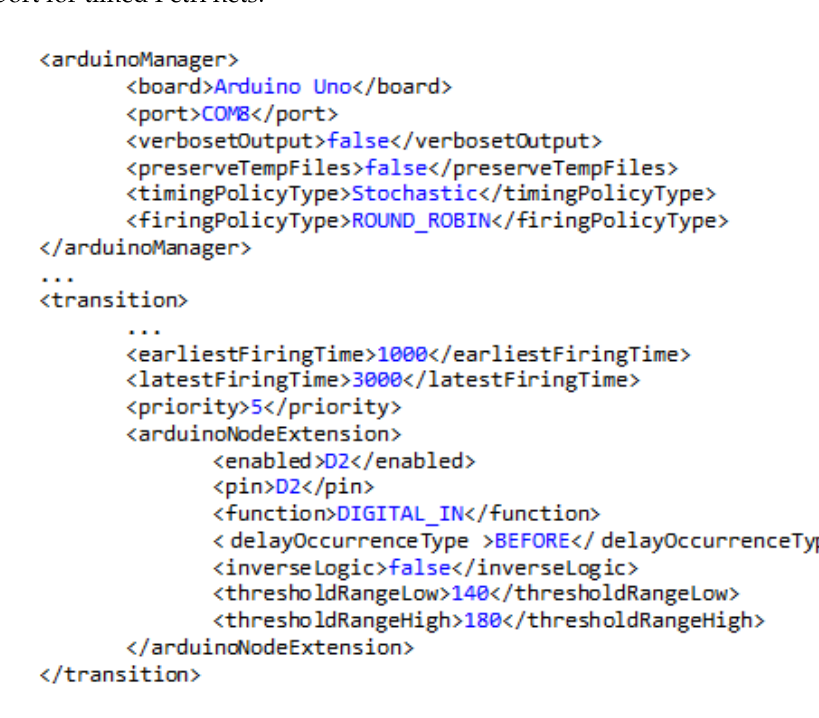
Figure 8. Part of the XML file describing the connection to Arduino.